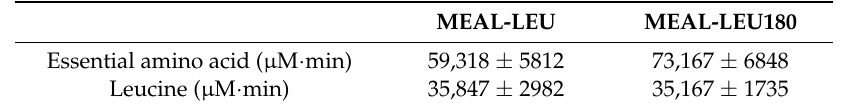
Table 7. Area under the curve with respect to increases (total Leucine intake of 4 g groups).